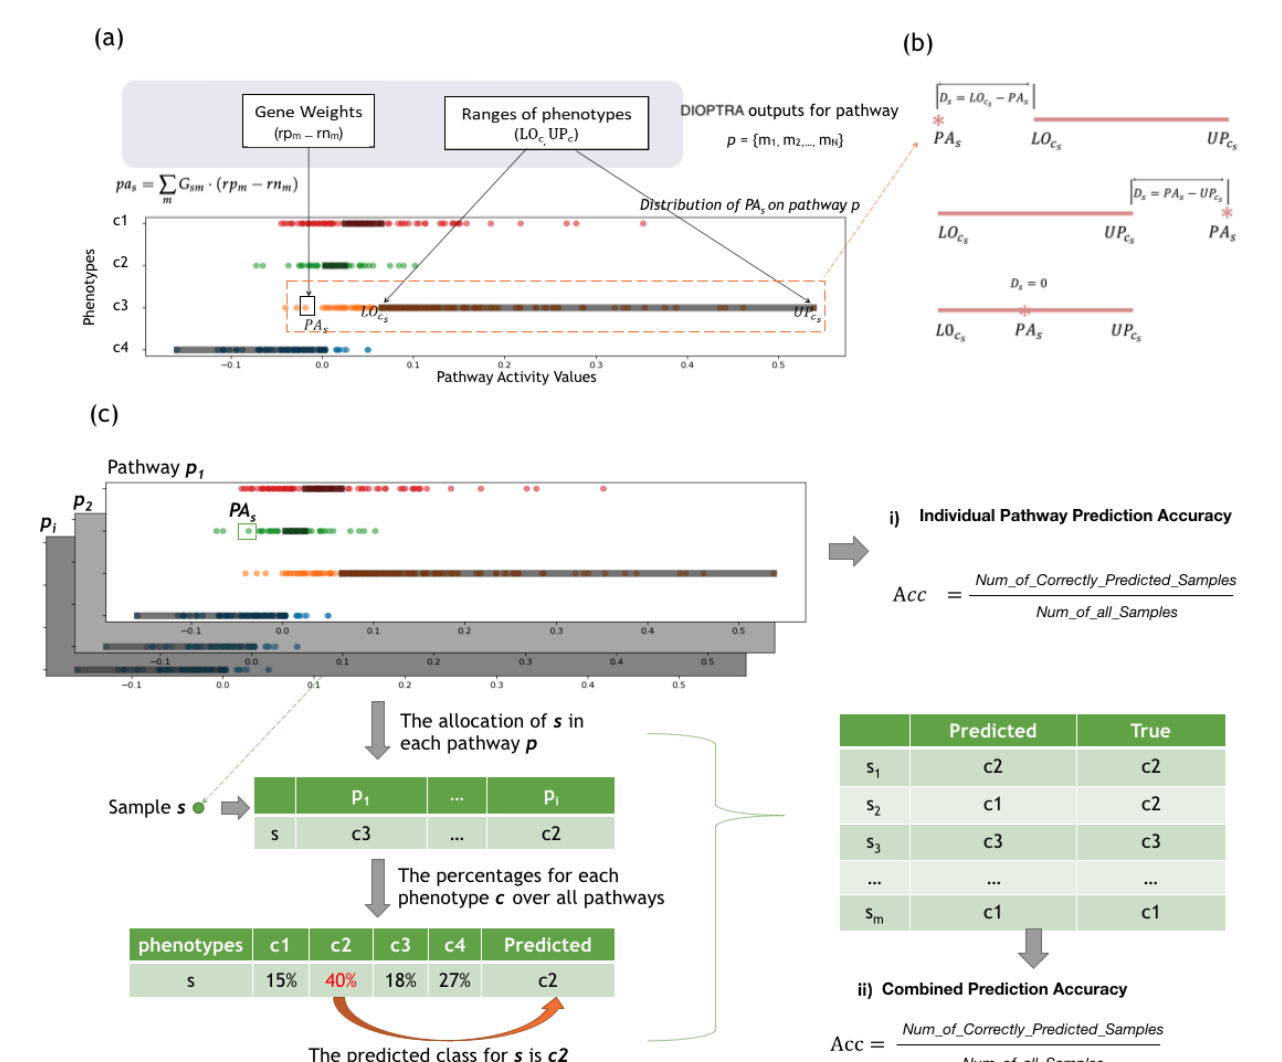
Figure 2. Individual Pathway Evaluation. ( a ) Motivating Example of the DIOPTRA model. DIOPTRA seeks to infer pathway activity as a discriminative feature for sample classes. Pathway activity ( pa s ) is defined as the weighted linear summation of expressions of constituent genes m , where the gene weights ( rp m − rn m ) are modelled as free variables. On the pathway activity dimension, each ] , represented by the black boxes), and classes do not class occupies a distinct range ( [ LO c , UP c s s overlap. The points indicate samples coloured according to class, while values are pa s . ( b ) Three ] . The distance between the pa s and its corresponding possible scenarios between pa s and [ LO c , UP c s s [ LO c ] is the sample violation distance D s . ( c ) Two applications of the outputs of the DIOPTRA , UP c s s model. (i) Individual Pathway Prediction Accuracy: after pa s values are obtained, samples are allocated into the nearest class range, then accuracy for p is calculated as the percentage of samples that are allocated to the correct class. (ii) Combined Prediction Results: after obtaining sample allocations from all pathways, the predicted class for s is the one with the highest number of pathways; the combined accuracy is then calculated after dividing the number of correctly predicted samples by the